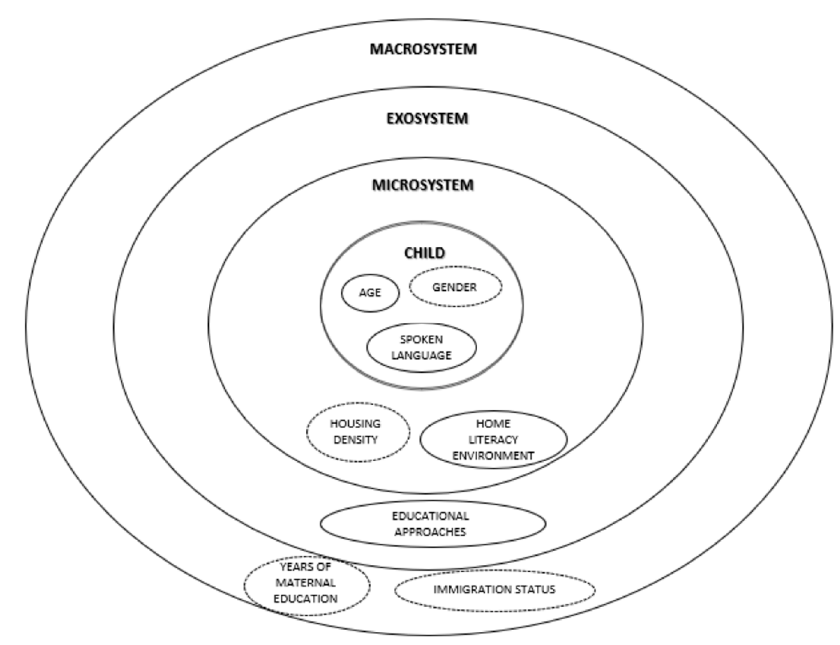
Figure 1. Bronfenbrenner’s bioecological model of human development (Notes. Variables located in